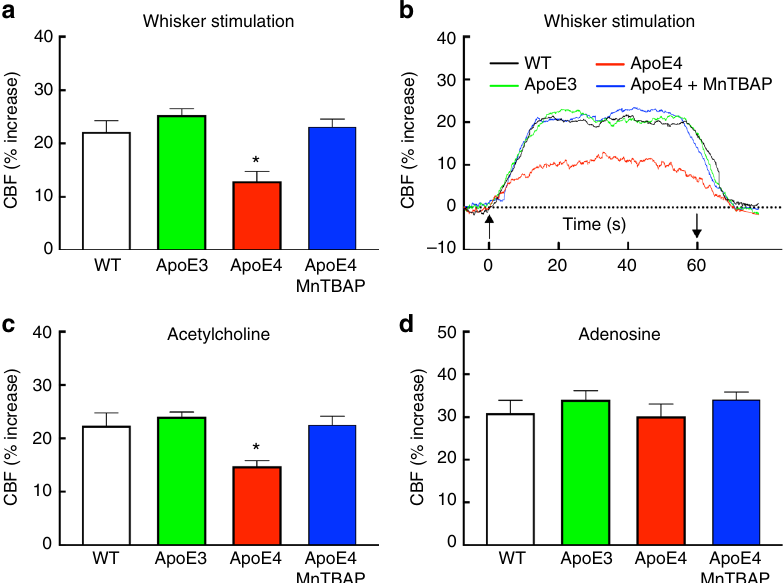
Fig. 2 CBF dysfunction in ApoE4-TR mice is reversed by MnTBAP. The increase in CBF induced by whisker stimulation ( a , b ) or by neocortical application of acetylcholine ( c ), is attenuated in ApoE4-TR mice, but CBF response to neocortical application of adenosine ( d ) is not affected. Neocortical superfusion with the ROS scavenger MnTBAP restores neurovascular function in ApoE4-TR mice ( a – c ). Data are expressed as means ± SEM. N = 5/group; * p < 0.05 from WT or ApoE3, or ApoE4 + MnTBAP; one-way ANOVA and Tukey ’ s